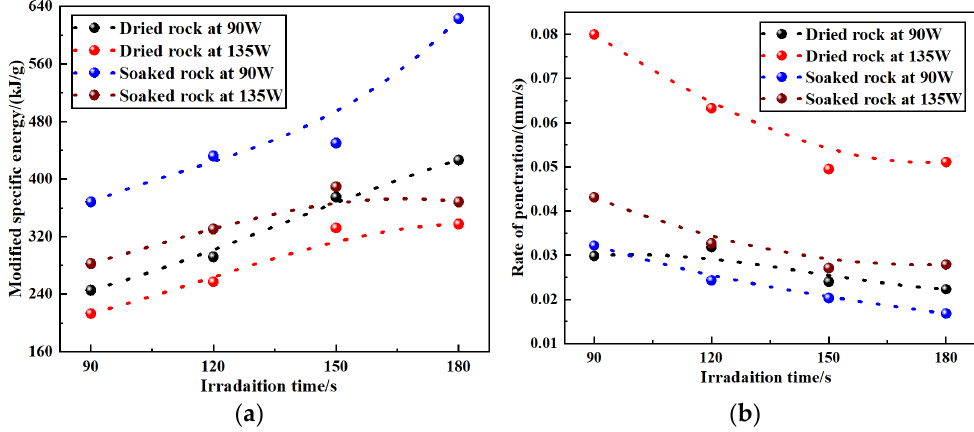
Figure 8. Plots of ( a ) modified specific energy versus irradiation time; ( b ) rate of perforation versus irradiation time.